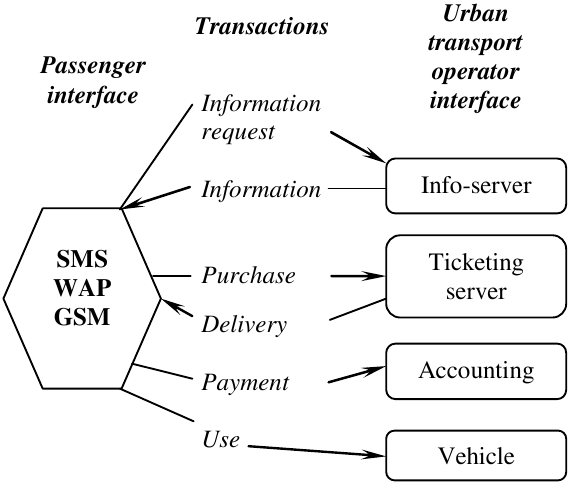
Fig 3. A generic example of